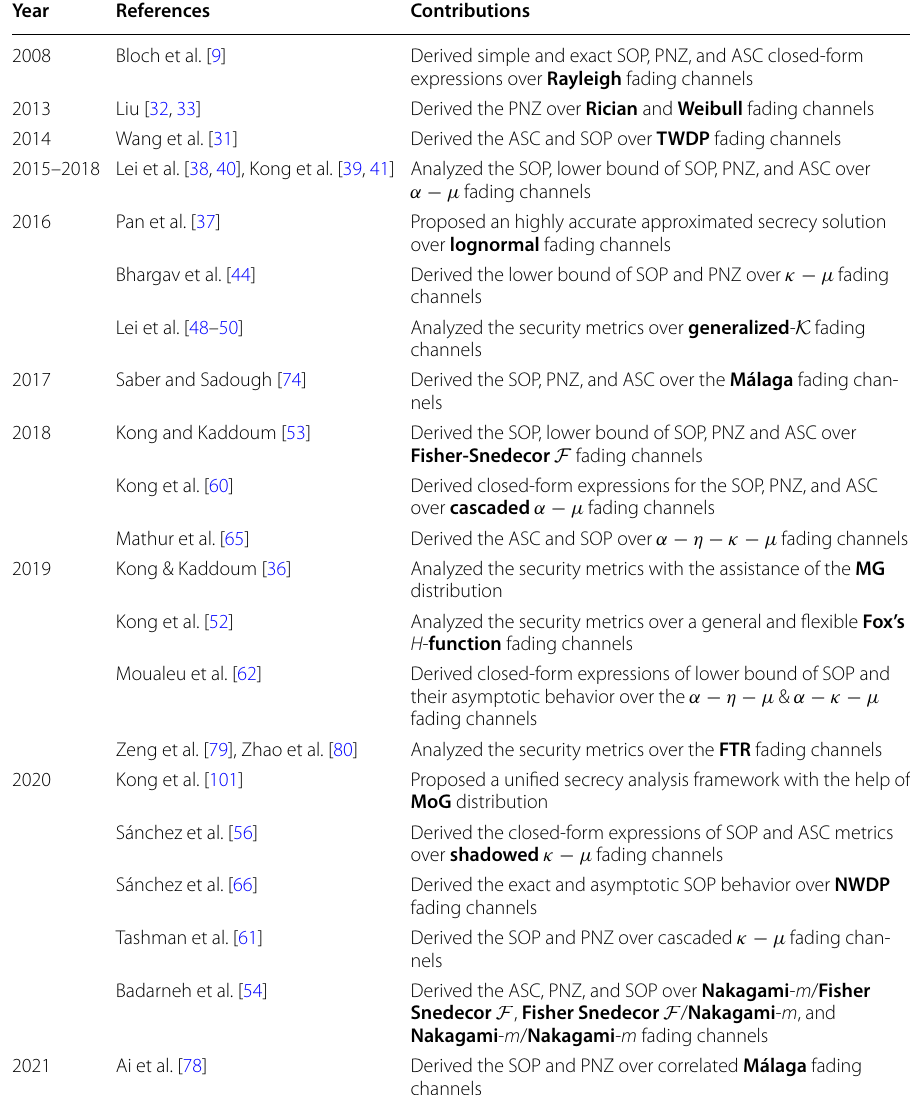
Table 2 Major information-theoretic secrecy analysis works over the classic wiretap fading channels